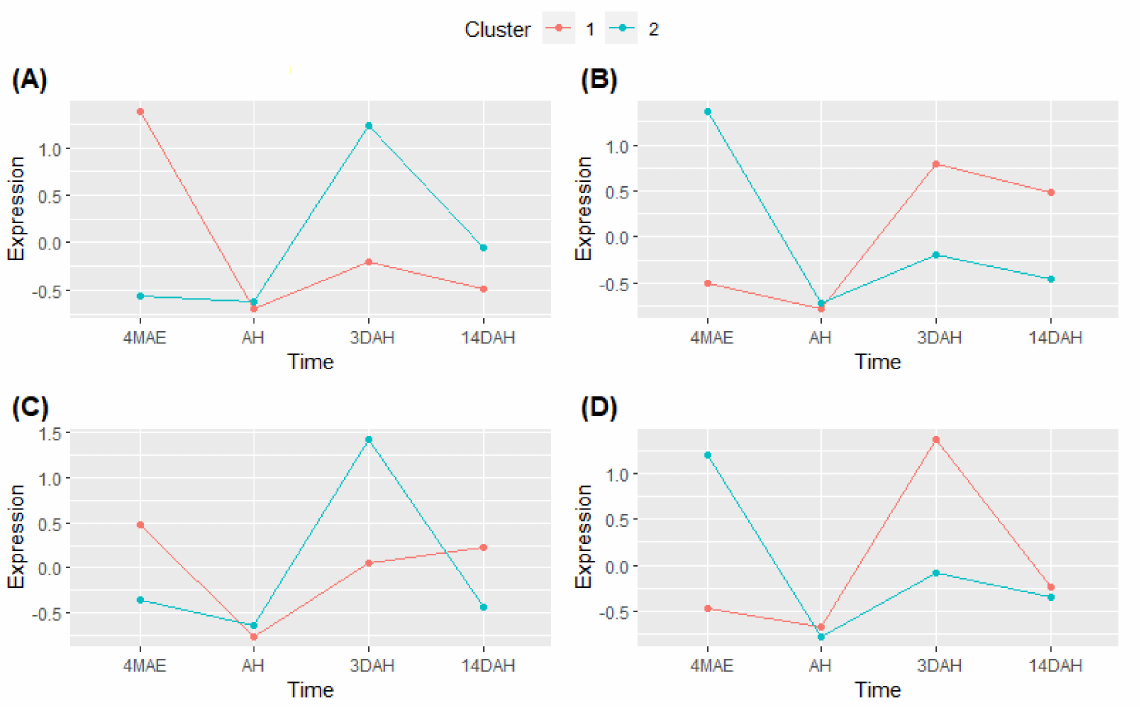
Figure 6. Cluster analysis of DEGs 3DAH among the different sampling times 4MAE and after harvest. ( A ) Bangou 1, ( B ) Bayangam 2, ( C ) Fonkouankem 1, ( D ) combined analysis of the three hardening